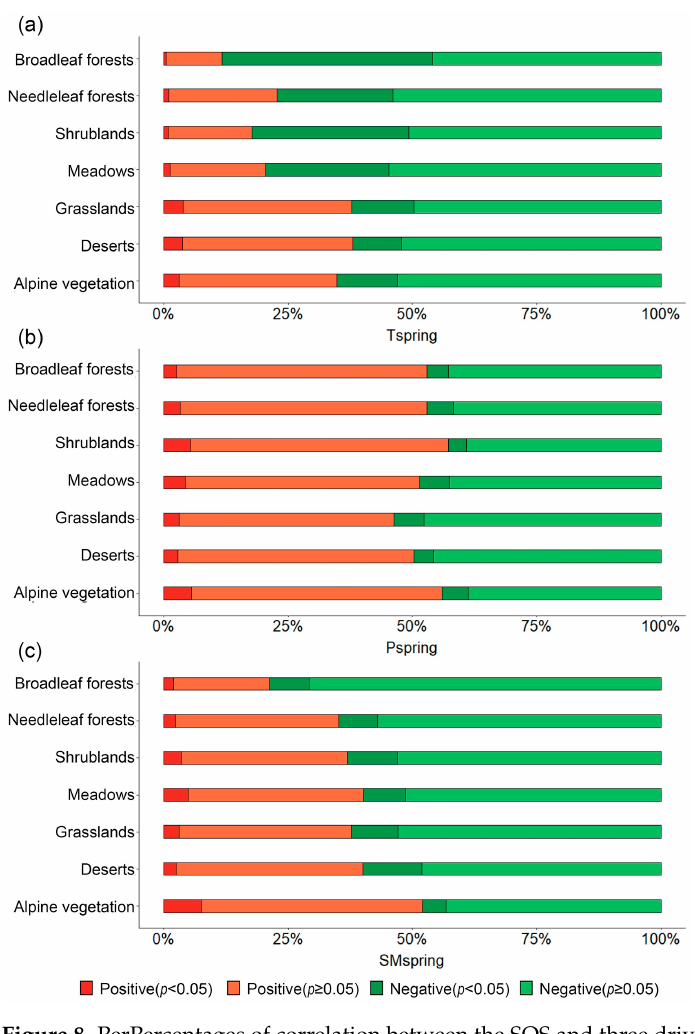
Figure 9. Percentages of correlation between EOS and different driving factors in different vegeta- tion types. The driving factors were ( a ,b, c ) seasonal temperature (Tspring, Tsummer, and Tautumn are spring, summer, and autumn temperature, respectively), ( d ,e, f ) seasonal precipitation (Pspring, Psummer, and Pautumn are spring, summer, and autumn precipitation, respectively), and ( g ,h, i ) seasonal soil moisture (SMspring, SMsummer, and SMautumn are spring, summer, and autumn soil moisture, respectively).